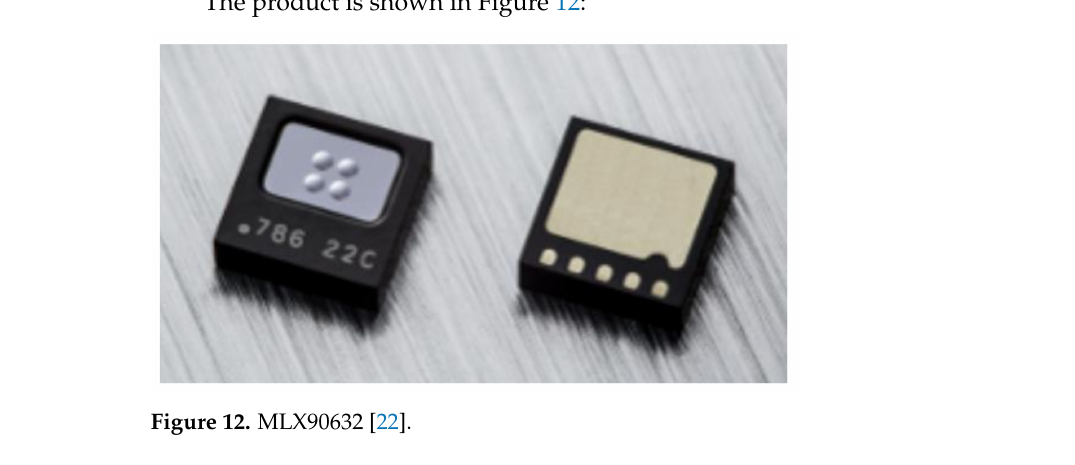
Table 6. Notes for BRAUN NTF3000 [23].